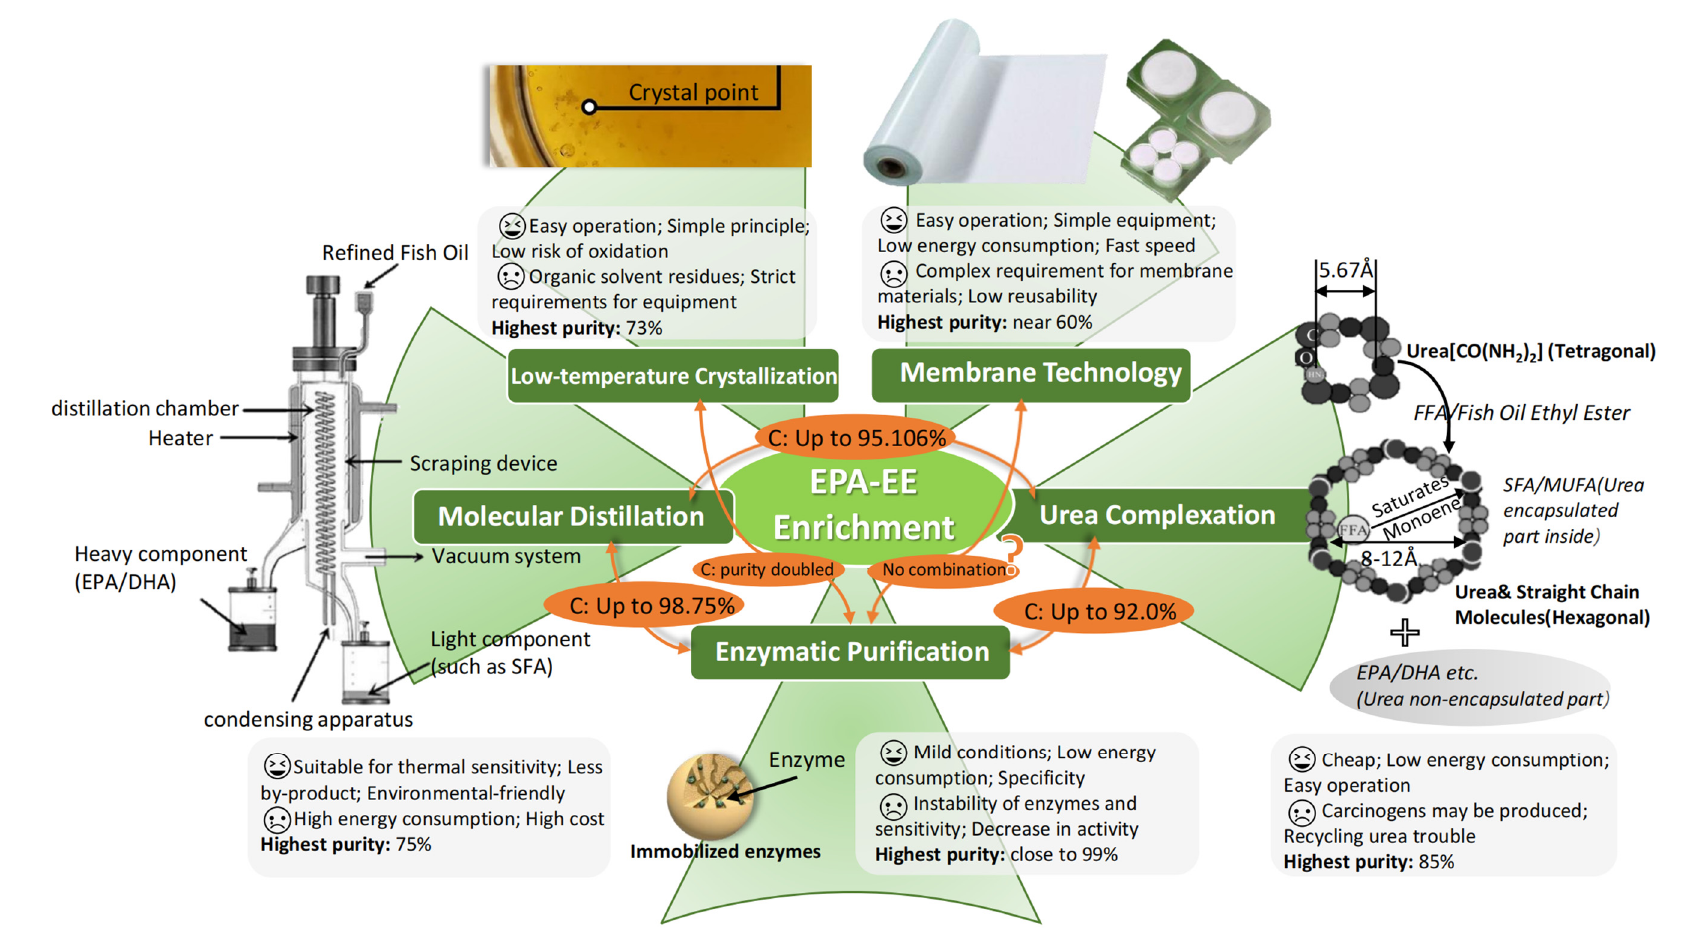
Figure 3. An overview of the features of EPA-EE enrichment technologies and the results of the combination of these technologies. C, combination; the orange double-headed arrow indicates a combination of methods; highest purity generally means the highest concentration achieved by the EPA-EE mixture; smiley faces indicate the advantages of the technology, and sad faces indicate disadvantages.